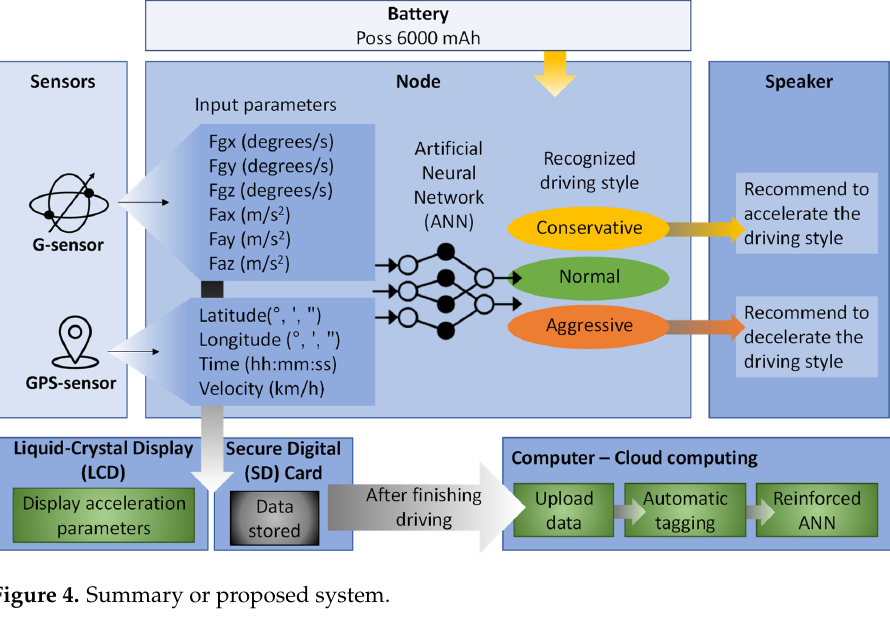
Figure 4. Summary or proposed system.